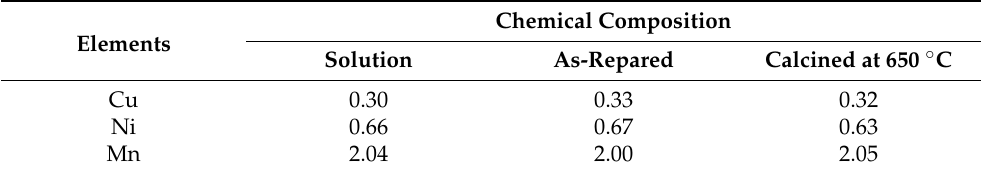
Table 1. Chemical composition of the fabricated powder.